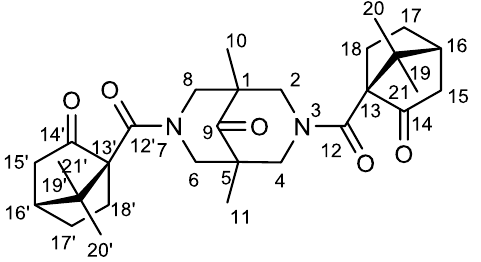
Figure 1. The structure of compound 35 with atom numbering